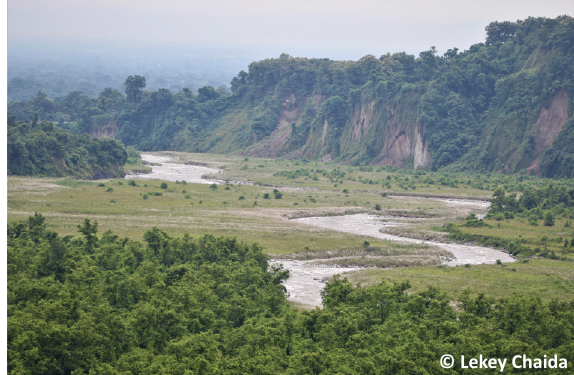
Image 4. Habitat of Boiga quincunciata in Jomotsangkha Wildlife